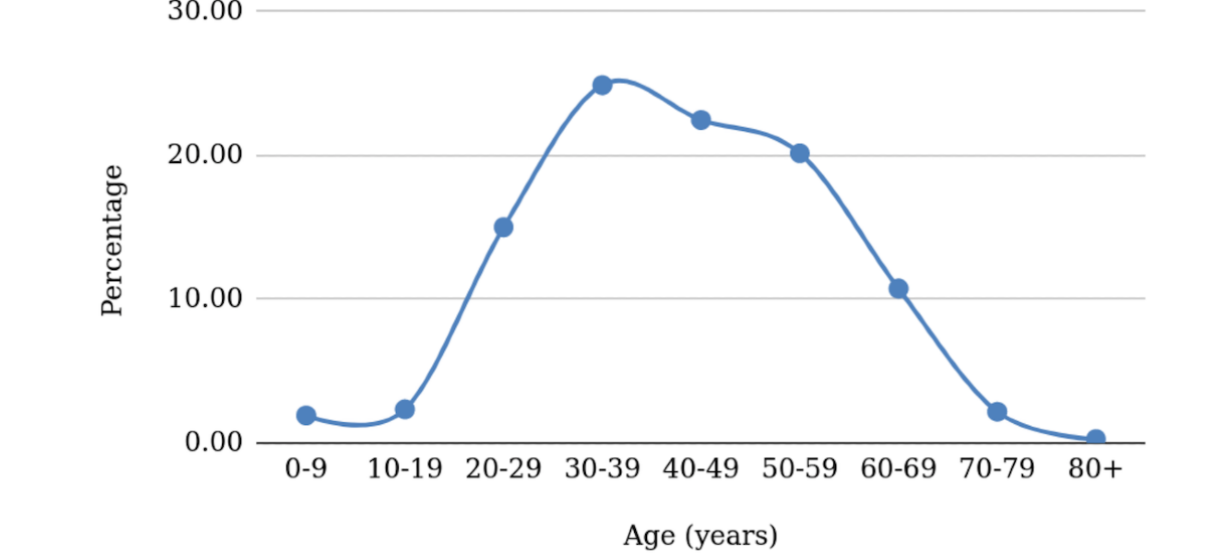
Figure 2. Projected age-stratified percentages of cases for the Philippines.